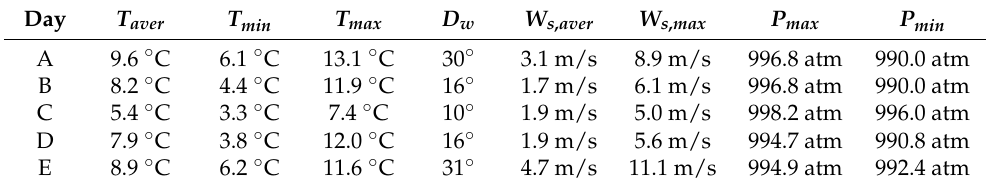
Table 2. Meteorological variables of the reference days A, B, C, D, and E. Information prepared by the Agencia Estatal de Meteorolog í a of Spain (data collected at the Valdespartera Station, Zaragoza Spain, 23 December